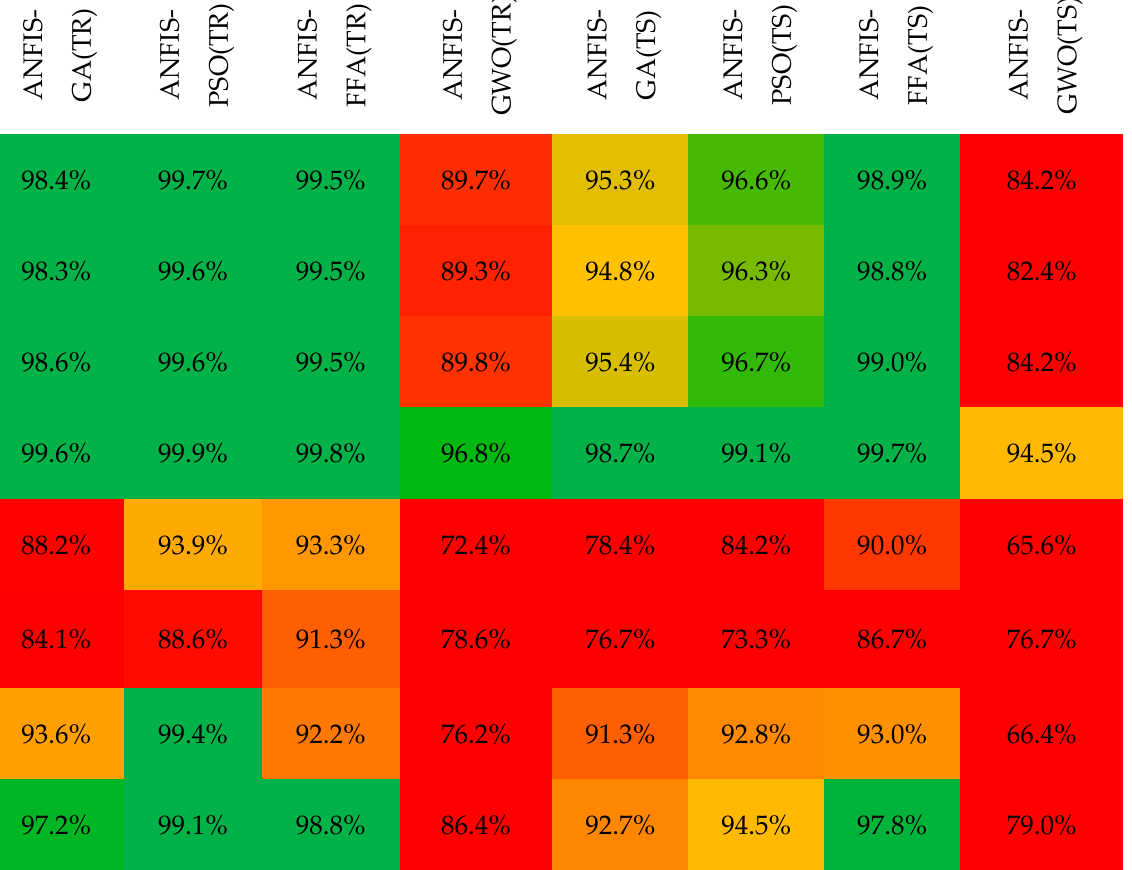
Figure 9. Accuracy matrix for hybrid ANFIS model (training and testing dataset).